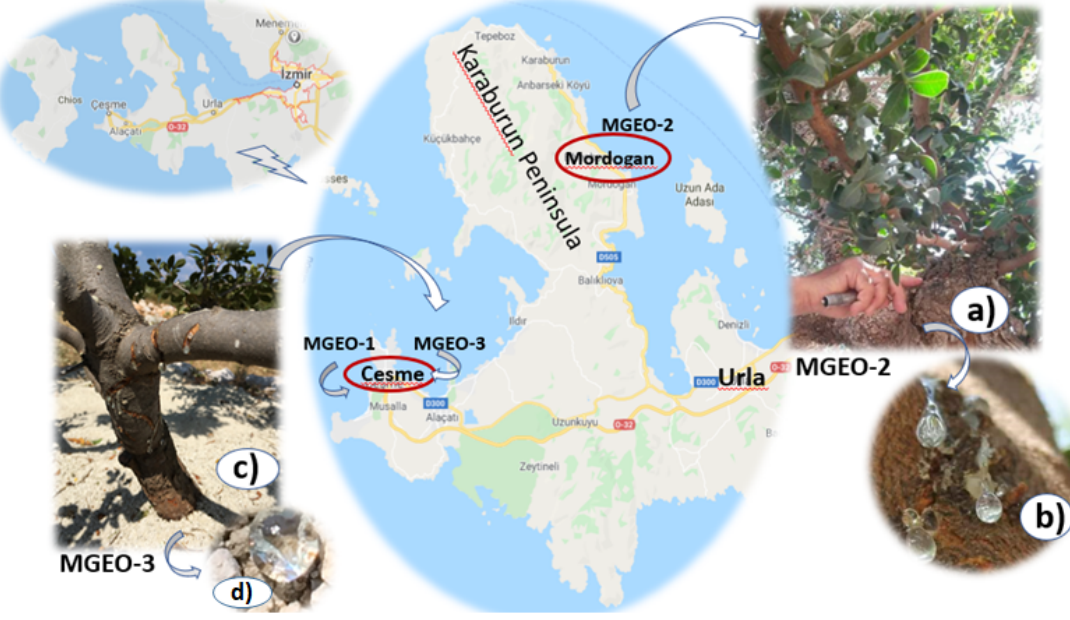
Figure 4. Map (www.google.com/maps) of Izmir showing regions where mastic gum samples were collected from Cesme (MGEO-1, wild and MGEO-3, cultivated) and Mordogan (MGEO-2, wild); ( a ) the tree trunk in Mordogan is “injured” with incisions; and ( b ) mastic tears flowing down from a wounded tree. Photos courtesy of A.N. ( c ) Injured bark on a cultivated tree in Cesme, Germiyan village; and ( d ) fresh mastic tear fallen to the ground. Photos courtesy of Ali Efe Karci.